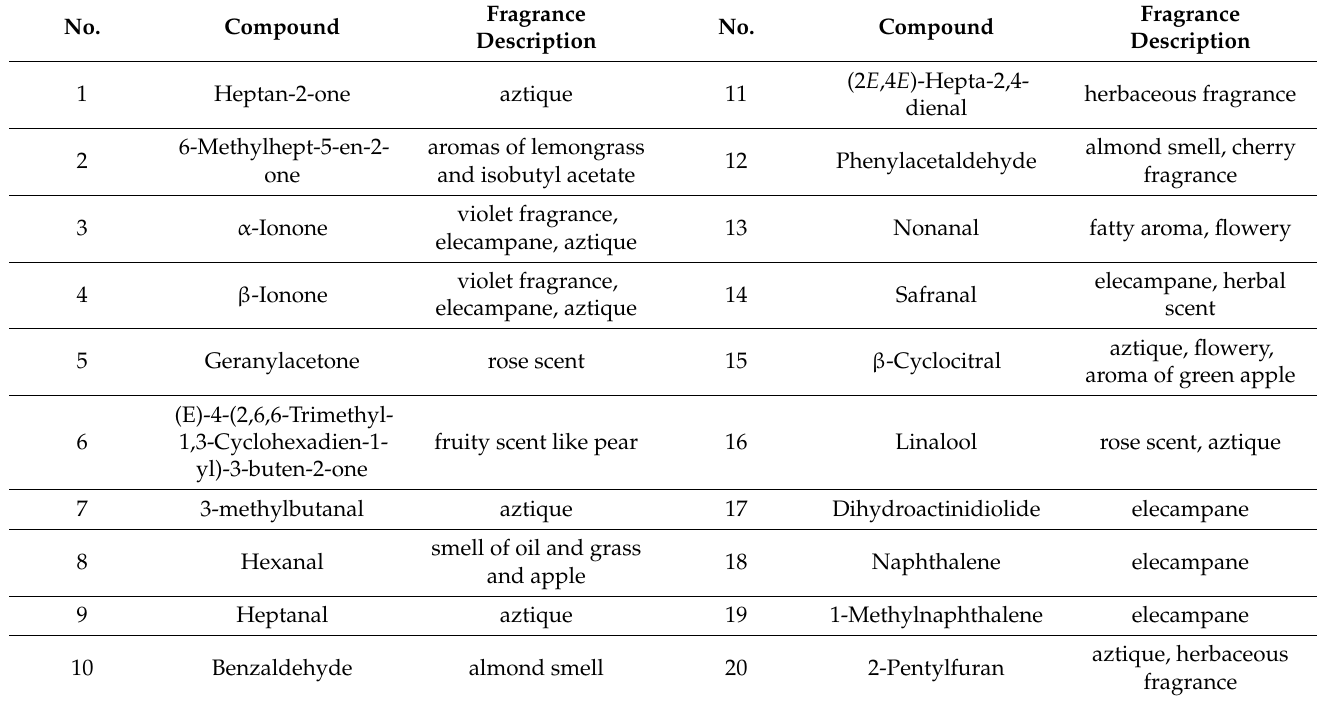
Table 6. Aroma characteristics of the 20 volatile compounds found in all 4 samples of